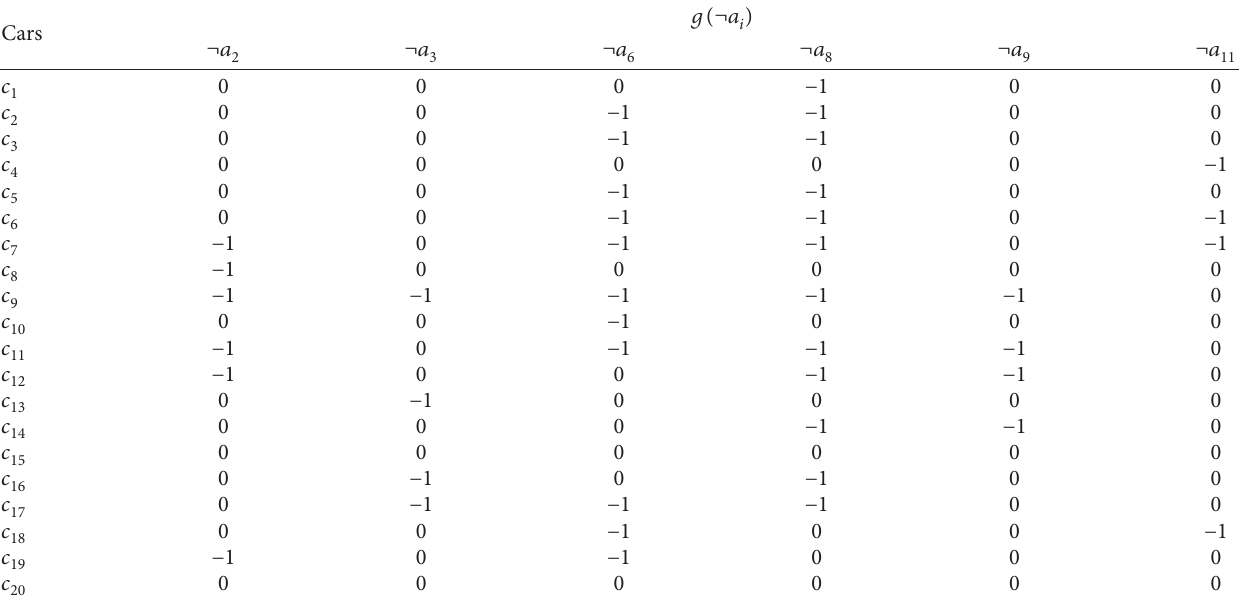
Table 2: The negative components g of bipolar soft sets ( f, g,E ) of each